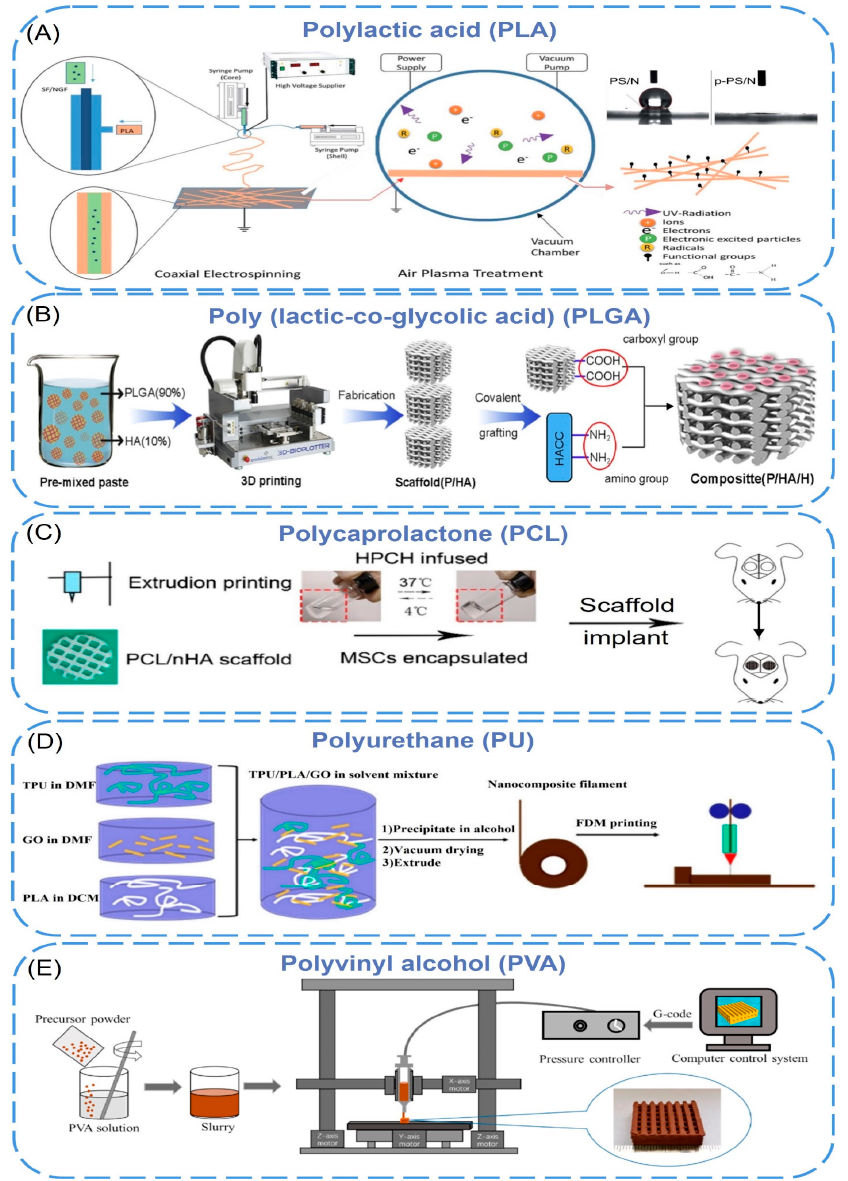
Figure 2. ( A ) Schematic illustration of the electrospinning and air plasma treatment towards